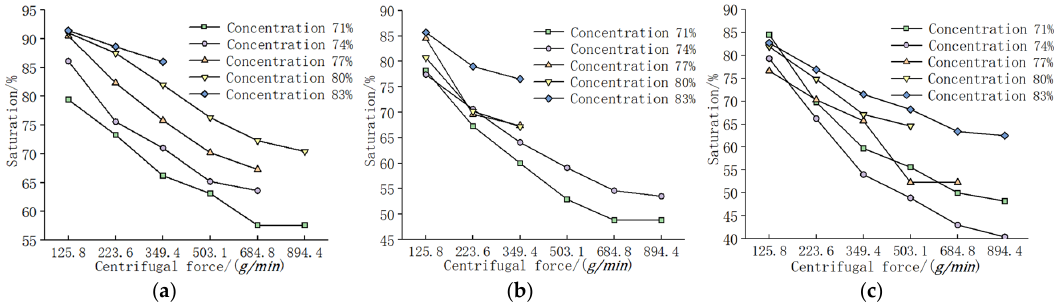
Figure 7. Analysis of the centrifugal force and saturation of the backfills with different concentrations and ratios. ( a ) cement–tailings ratio of 1:4; ( b ) cement–tailings ratio of 1:8; ( c ) cement–tailings ratio of 1:12.